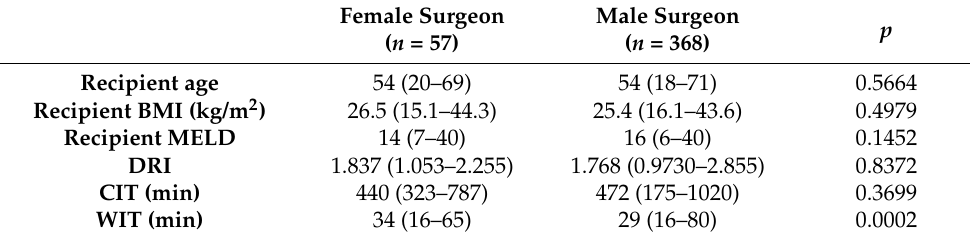
Table 3. Recipient, donor and surgical details stratified according to surgeon